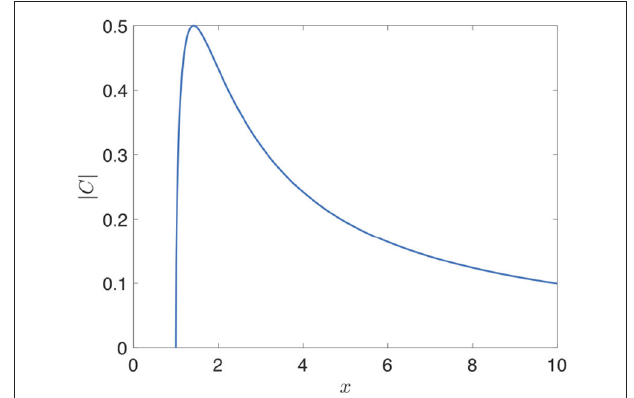
FIGURE 8 | Chirp as a function of stretch factor, x Equation (36).